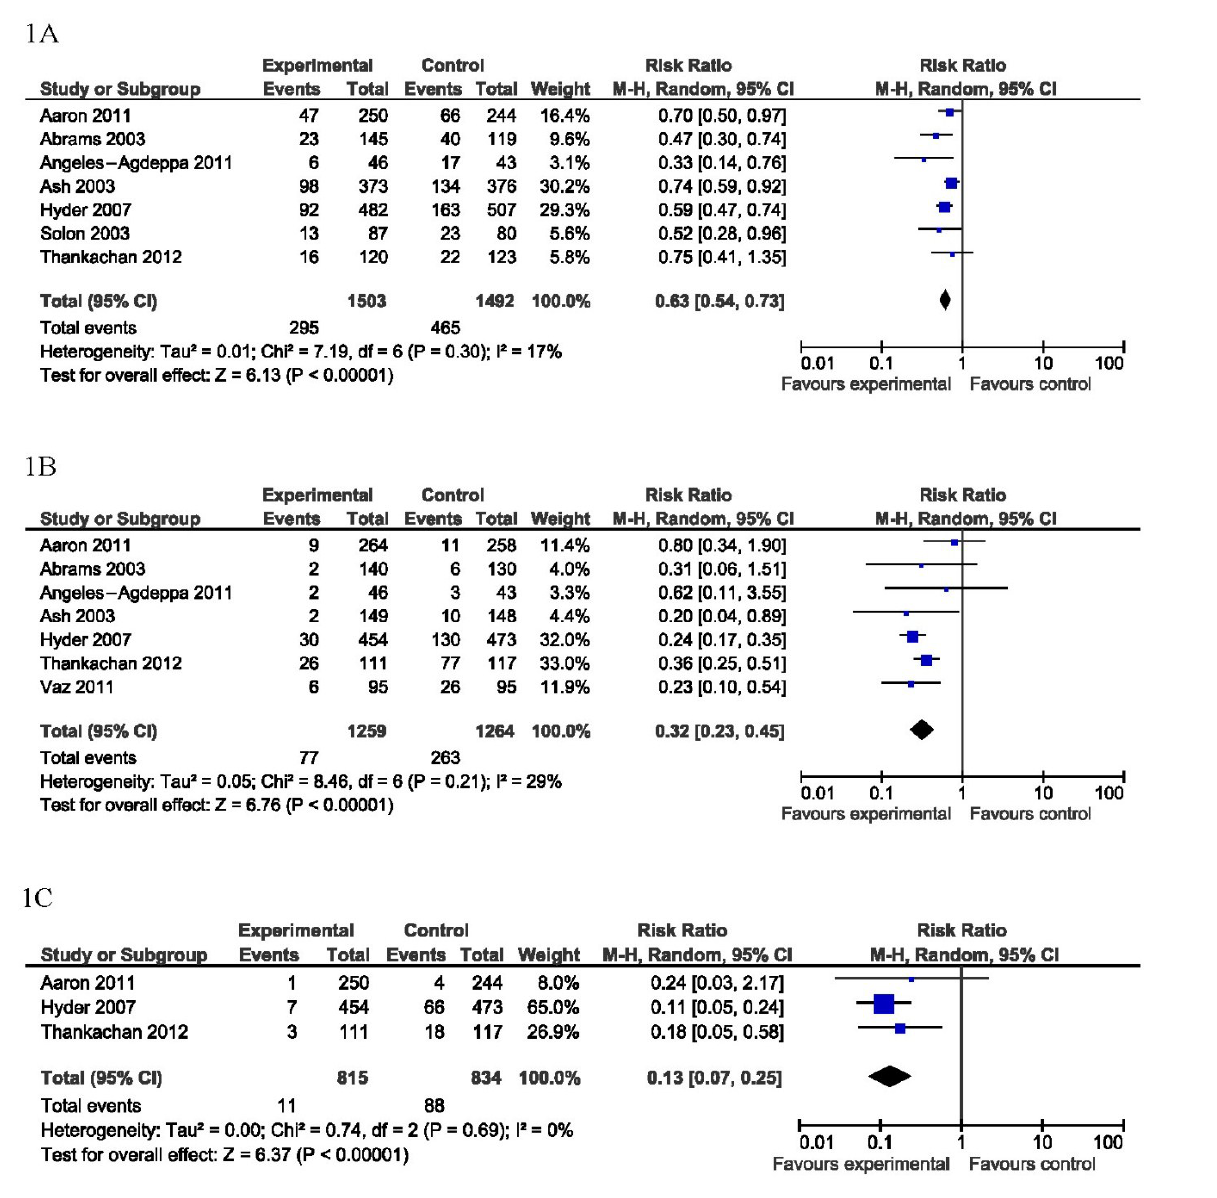
Figure 1. Forest plot of studies assessing hemoglobin and iron outcomes. Consumption of MMN beverages fortified compared to iso-caloric controls significantly reduced the risk of anemia ( 1A ); iron deficiency ( 1B ); and iron deficiency anemia ( 1C